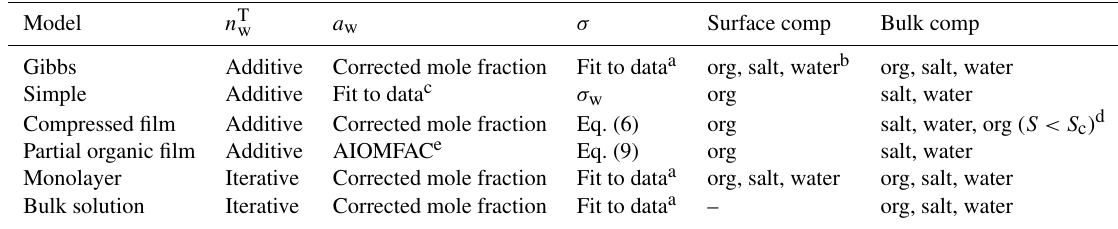
Table 1. Methods of calculating the total amount of water ( n T w ) in the droplets, the droplet water activity ( a w ) and surface tension ( σ ), and the composition of the droplet surface and bulk phases used with the different models. Details of the water activity and surface tension equations are given in Sects. S2 and S4 of the Supplement.